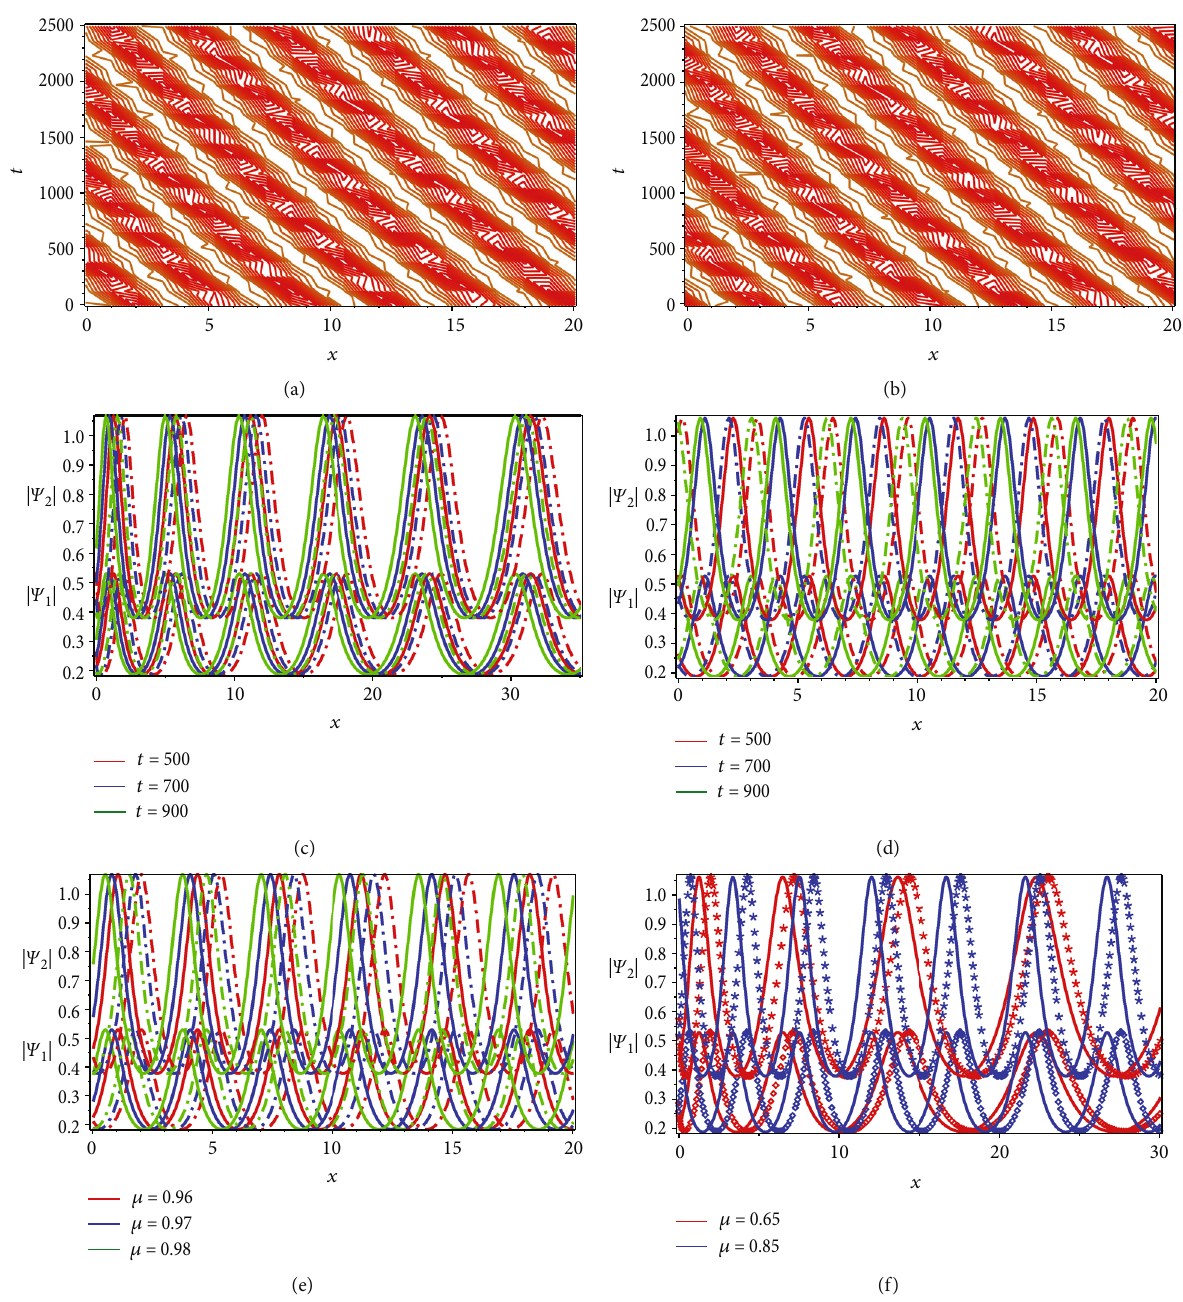
x , t Þj of Equation (54) for (a) BFD parameter μ = 0 : 95 and (b) CFD parameter μ = 0 : 95 , and 2D wave pro fi les Figure 6: Contour plots of j Ψ 1 ð (solid line=BFD; dash line =CFD) with the e ff ect of time for (c) μ = 0 : 75 , (d) μ = 1 and (e, f) with the e ff ect of fractional parameter for t = 900 . The remaining parameters are as in Figure